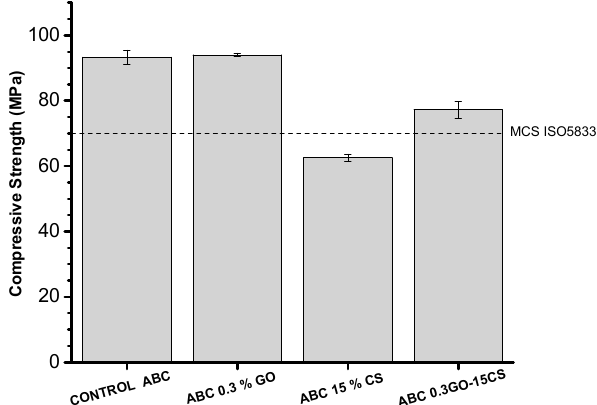
Figure 6. Compressive strength of the control ABC and experimental cements formulated with graphene oxide and chitosan. The dotted line indicates the minimum compressive strength (MCS) threshold defined by ISO5833.